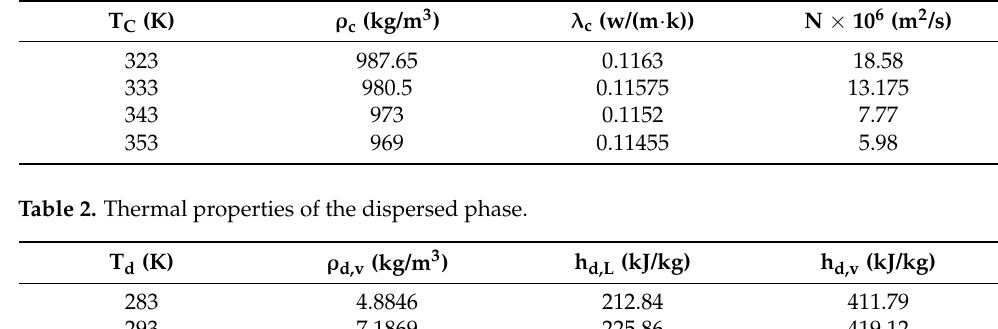
Figure 1. Schematic diagram of the experiment. 1: nozzle; 2: direct contact heat exchanger; 3: high-speed camera (5F01M, Revealer, China); 4: flowmeter; 5: thermometer; 6: pressure gauge; 7: condenser; 8: liquid storage tank; 9: centrifugal pump; 10: instrument display; 11: gear oil pump; 12: control cabinet; 13: electric heater. Table 1. Thermal properties of the continuous phase.